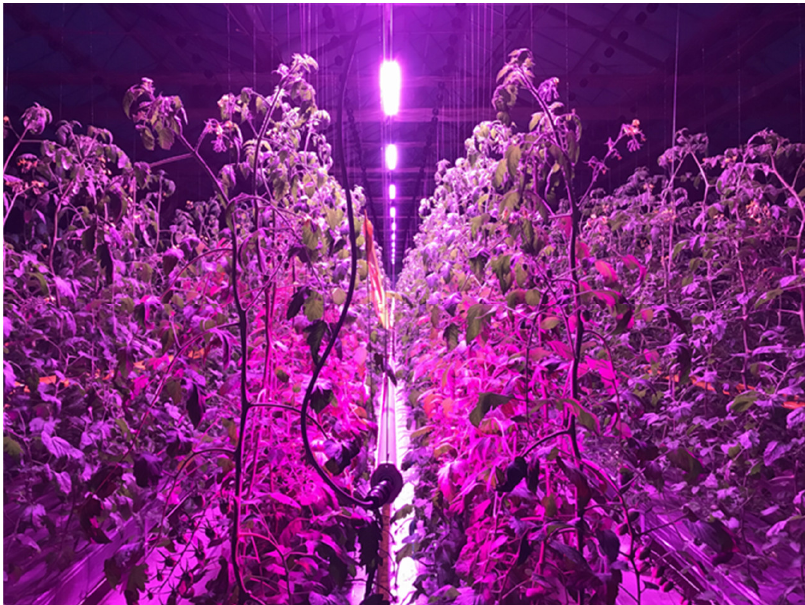
Figure 1. Supplemental light-emitting diode (LED) lighting under inter- + toplighting treatment with plants on 1 December 2018.